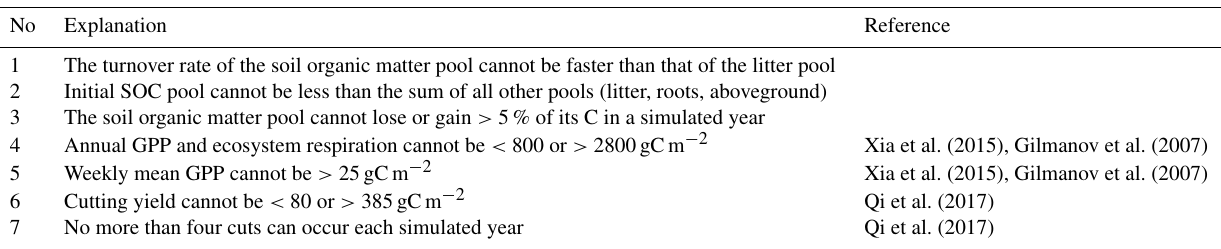
Table A2. Ecological and dynamic constraints